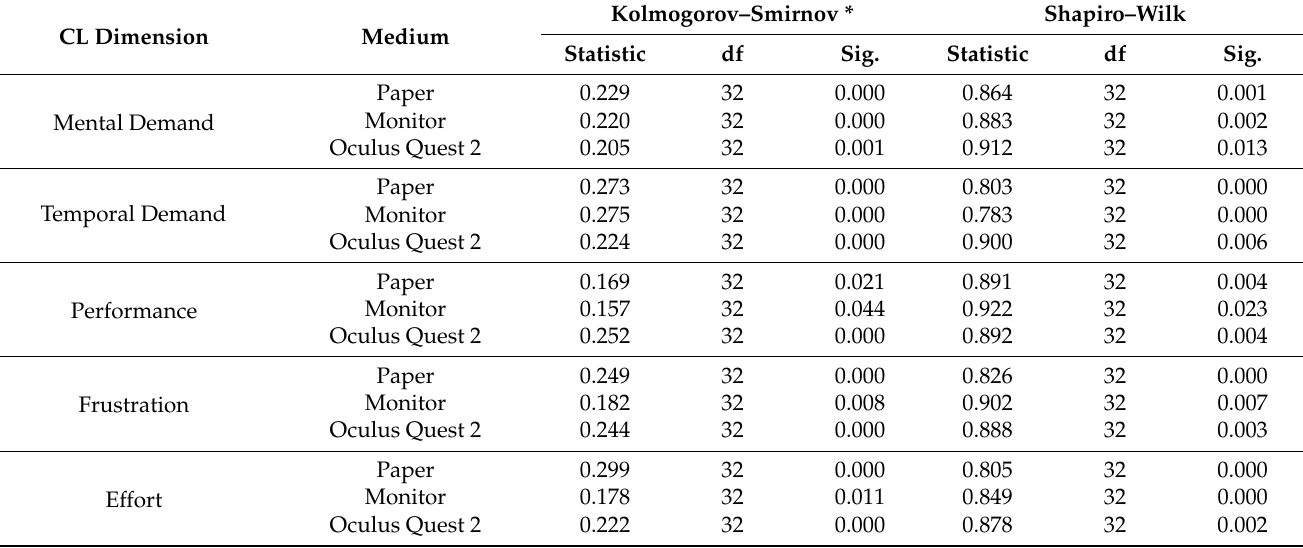
Table 3. Tests of